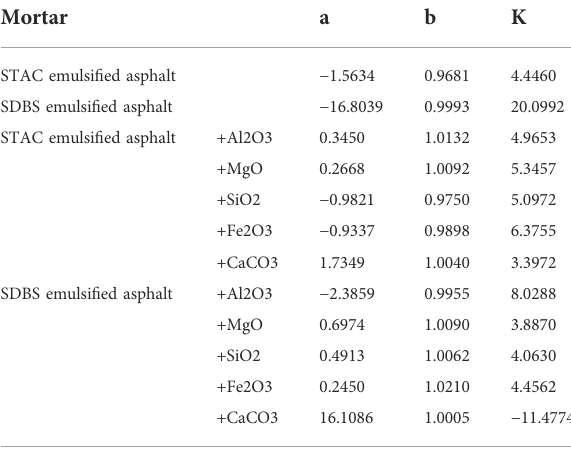
TABLE 6 Calculated values of the parameters of the Gompertz model for the different emulsi fi ed asphalt-aggregate systems.